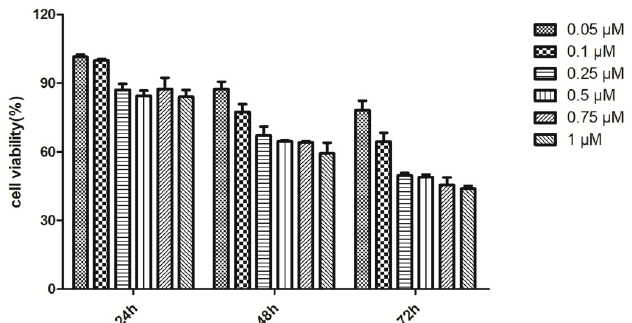
Figure 1. The effects of different concentrations of Rot on PC12 cell viability. PC12 cells (5 × 10 4 cells/mL) were treated with Rot for 24, 48, and 72 h at 37 °C. Cell viability was assessed by the MTT method as described in the Materials and Methods. The data are the means ± SDs. Values were obtained for three culture wells per experiment.